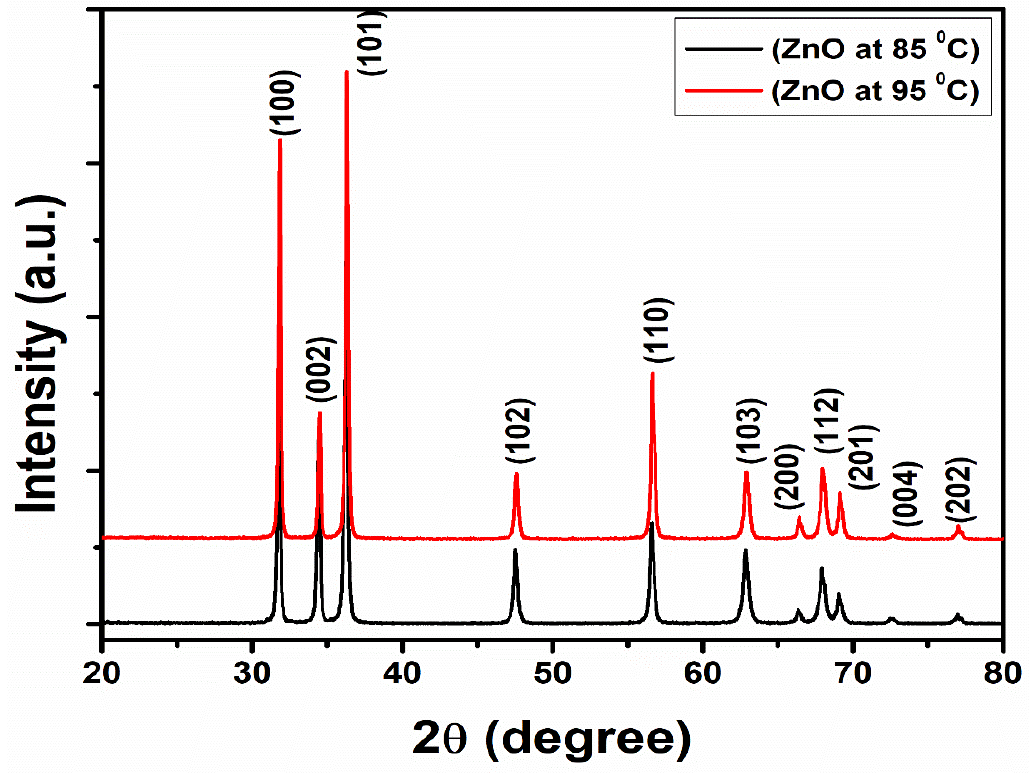
Figure 1. XRD patterns of ZnO prepared at different temperatures.